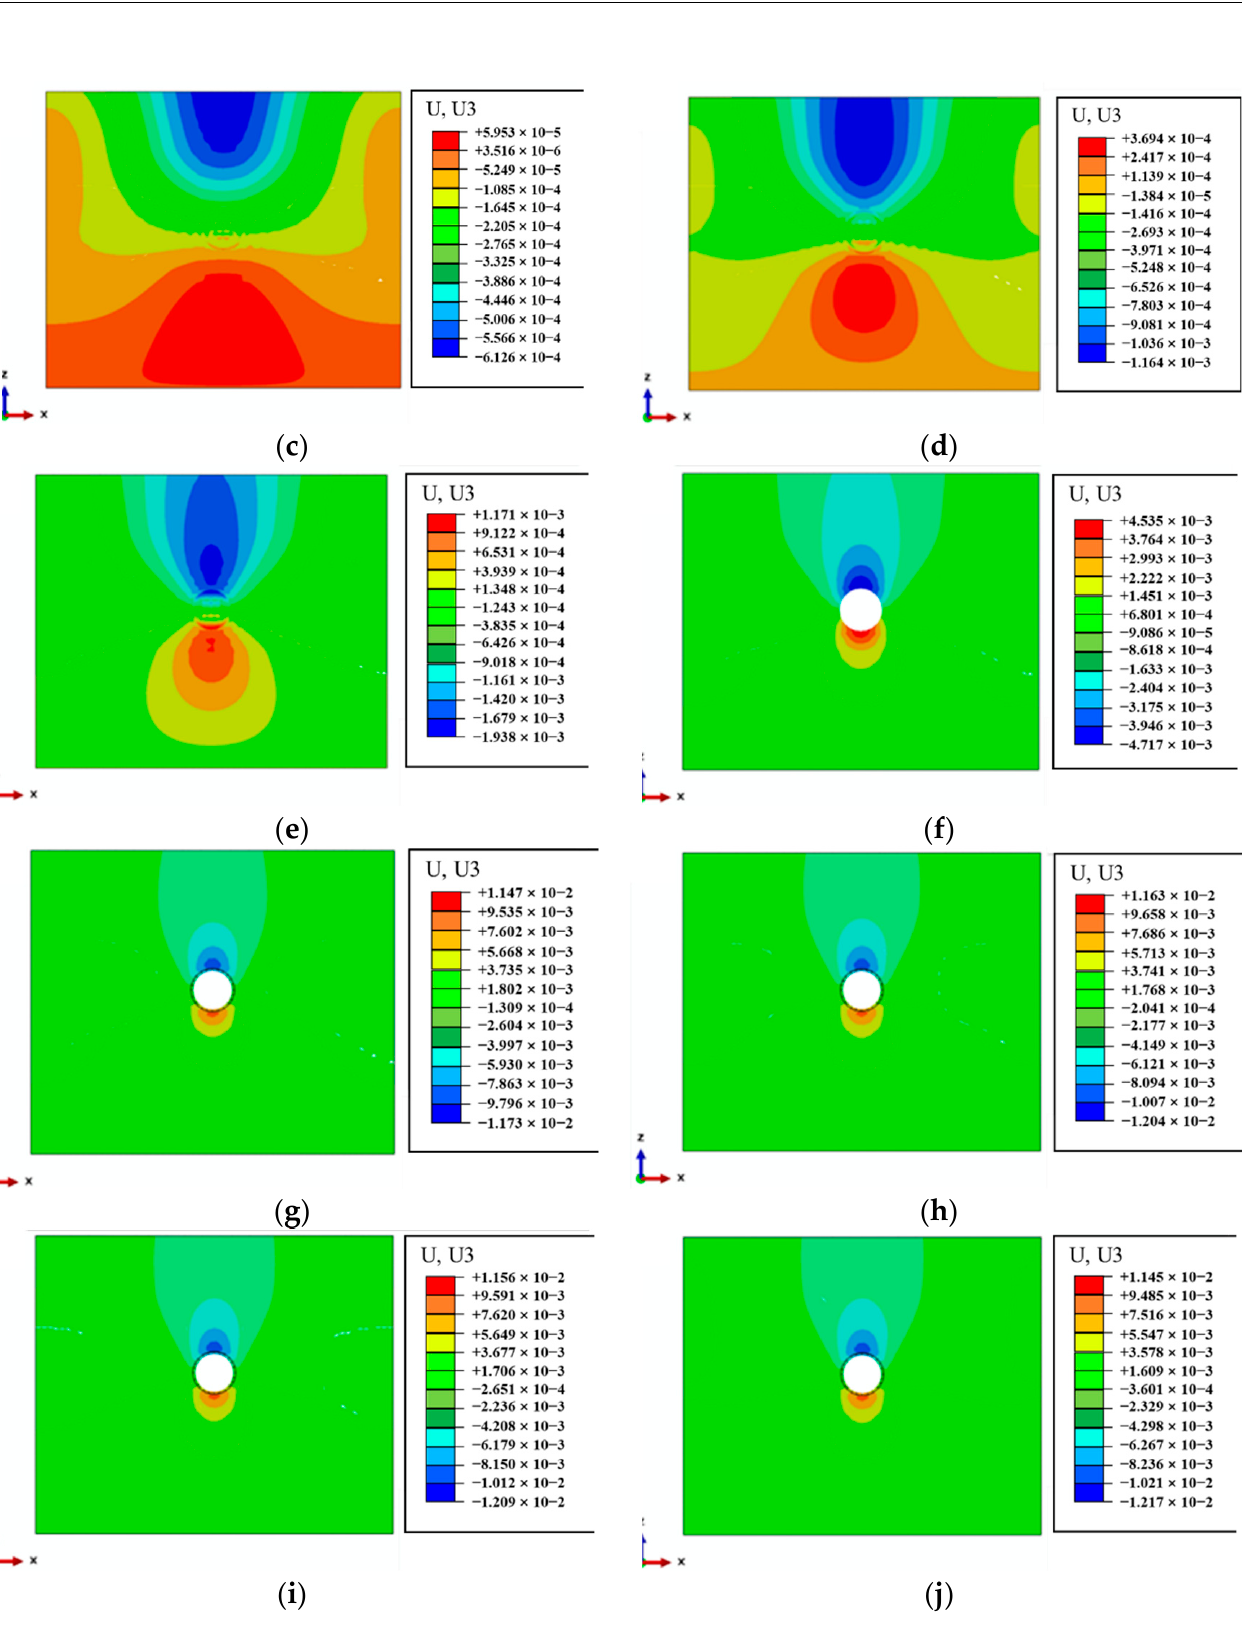
Figure 7. The cloud atlas of vertical displacement during different tunneling stages. ( a ) − 24 m. ( b ) − 18 m. ( c ) − 12 m. ( d ) − 6 m. ( e ) 0 m. ( f ) 6 m. ( g ) 12 m. ( h ) 18 m. ( i ) 24 m. ( j ) 30 m.